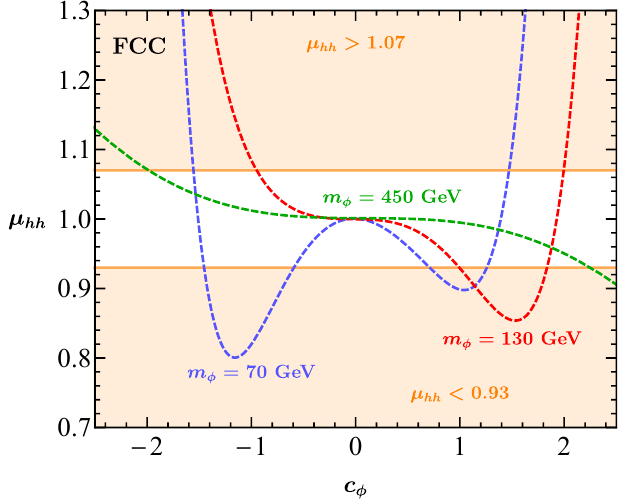
Figure 9 . The signal strength for double-Higgs production ( µ hh ) at the FCC as a func- tion of the Wilson coefficient c φ for three values of the scalar mass: m φ = 70 GeV (dashed blue), m φ = 130 GeV (dashed red) and m φ = 450 GeV (dashed green). The regions excluded by the projected experimental constraint µ hh ∈ [0 . 93 , 1 . 07] are shown in orange. For further expla- nations see main